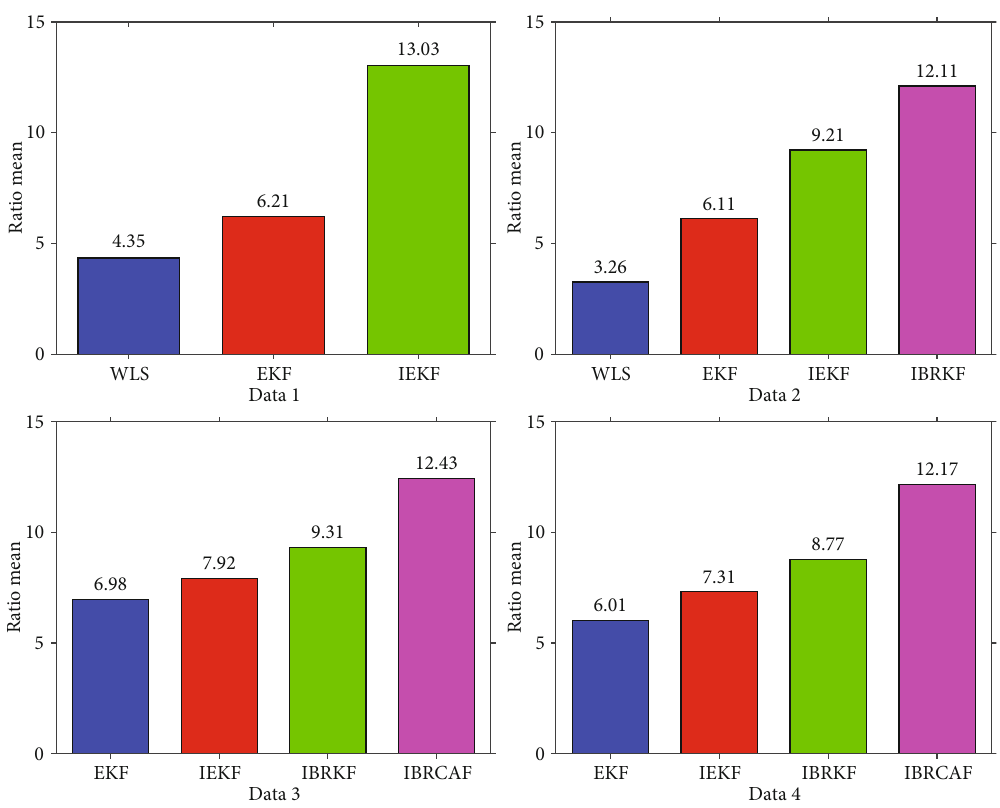
Figure 12: The ratio means of various schemes (Data 1 – 4). Table 2: The success rates of various algorithms for Data 1 – 4. Schemes Data 1 Data 2 Data 3